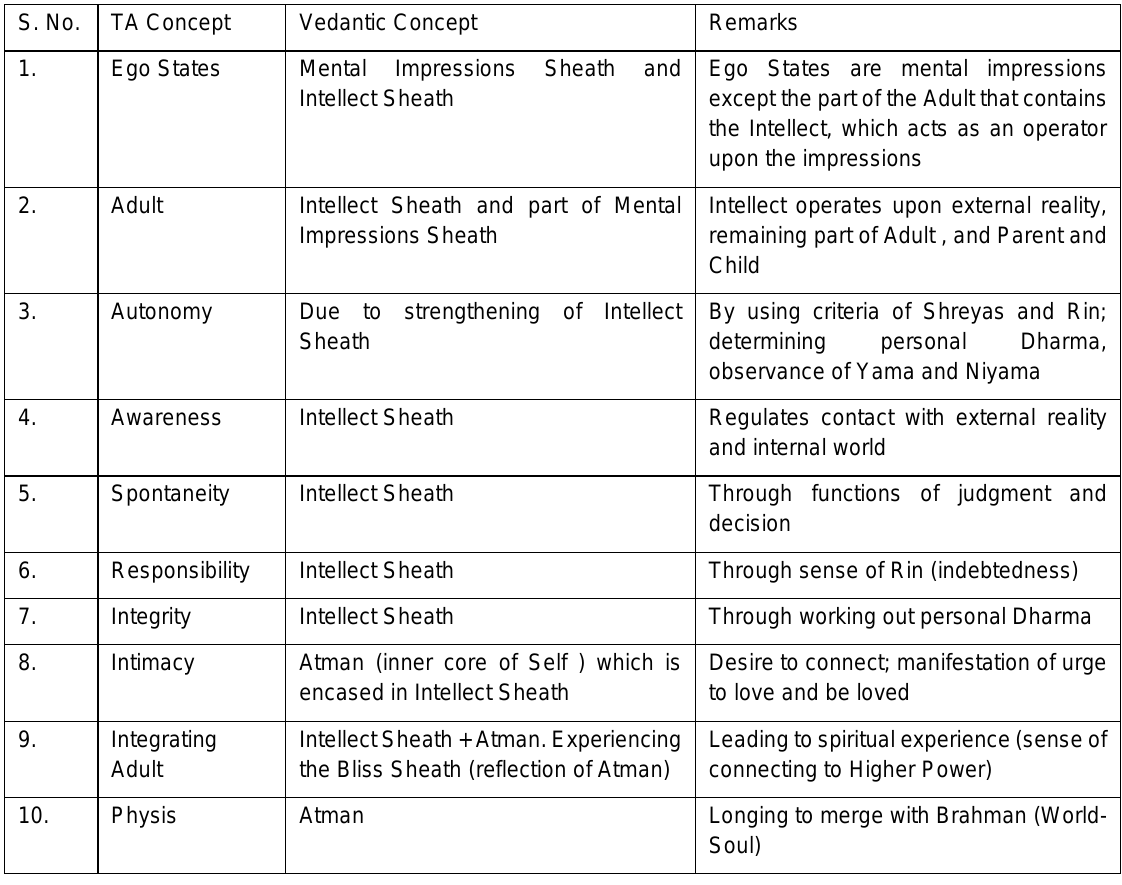
Table 3. Correspondence Between TA and Vedantic